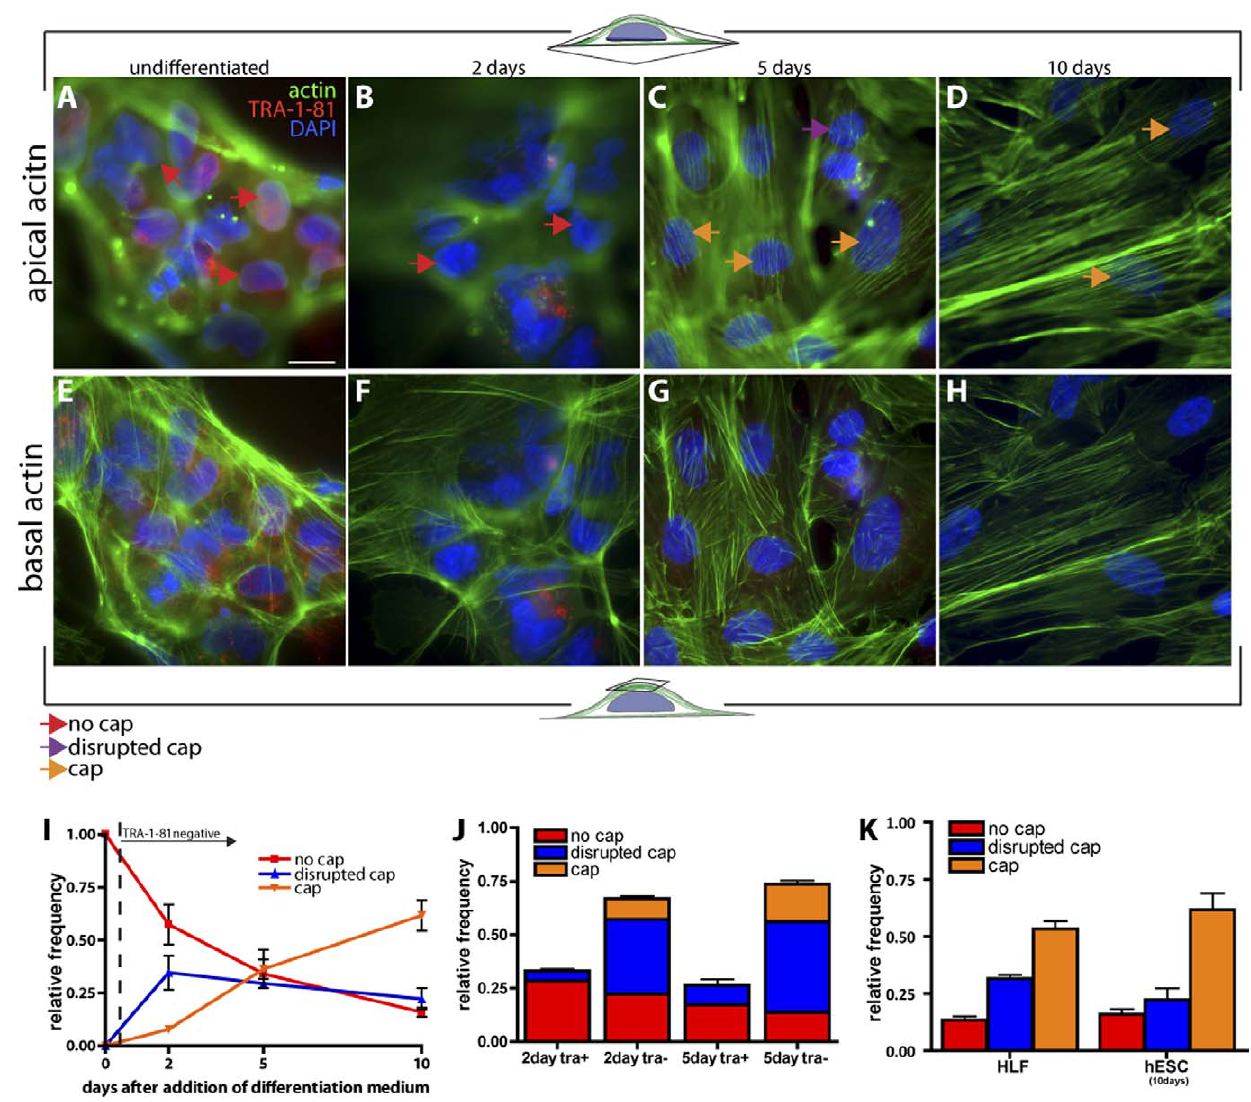
Figure 3. The perinuclear actin cap progressively forms in hESCs following onset of differentiation. A–H. Status of apical perinuclear actin cap (A–D) and basal stress fibers (E–H) in undifferentiated hESCs at day 0 (A and E), as well as two (B and F), five (C and G), and ten days (D and G) after induction of differentiation ( + VEGF and collagen IV). Red, purple, and orange arrows indicate examples of cells showing no actin cap, a disrupted/disorganized actin cap, and a well-organized actin cap, respectively. Cells were stained for differentiation marker TRA-1-81, nuclear DNA (DAPI), and actin. Scale bar, 20 m m. I. Evolution of the fraction of TRA-1-81-negative hESCs showing an actin cap. No actin cap was present in TRA-1- 81-positive hESCs. J. Proportion of TRA-1-81-positive and TRA-1-81-negative hESCs showing an organized actin cap, a disorganized actin cap, or no actin cap, two and five days after onset of differentiation. K. Distribution of cells showing an actin cap in hESCs after 10 days of differentiation compared to HLFs. At least 100 cells in triplicate for a total of 300 cells were probed per